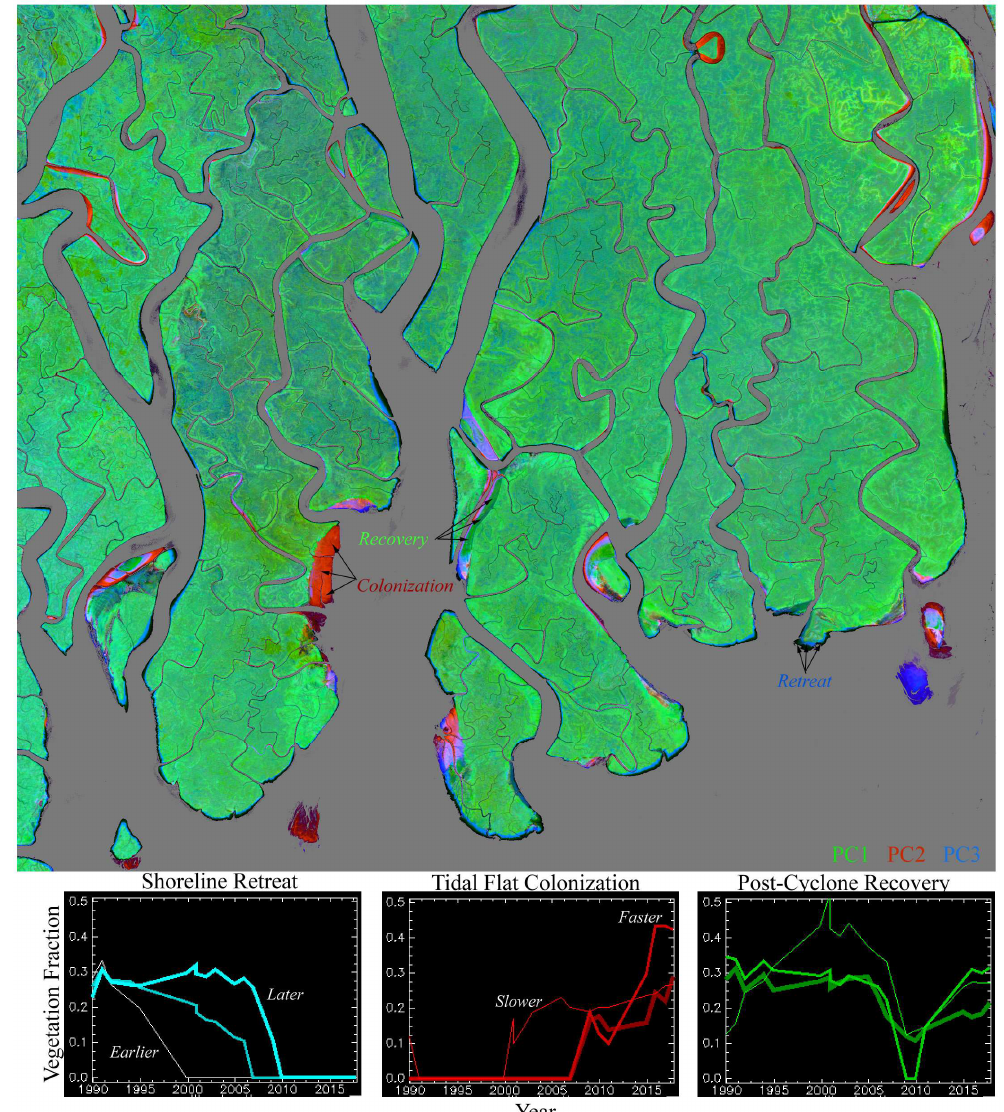
Figure 11. Interannual change map for Southeastern Bangladesh Sundarban 1989–2017. PC1 shows mean vegetation abundance while warmer and cooler colors show decadal increase and decrease of vegetation respectively. Shoreline and riverbank retreat from erosion are pervasive, particularly along the wider channels. Vegetation colonization of mudflats is more conspicuous but accounts for less area than is lost to erosion.